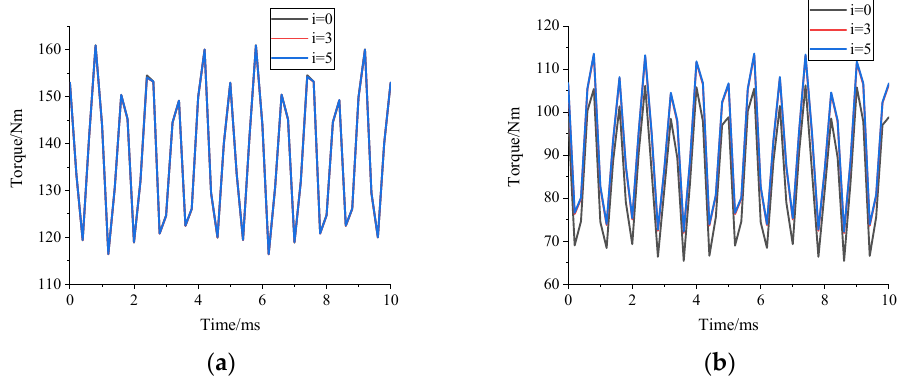
Figure 22. Motor output torque. ( a ) Output torque with the forward parallel permanent magnet;